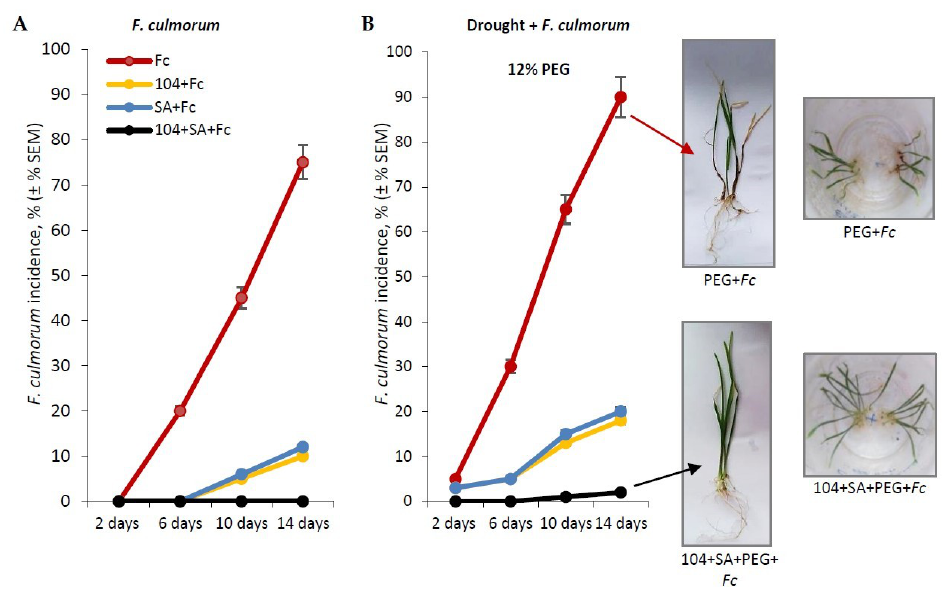
Figure 4. The influence of endophytic bacteria B. subtilis 10–4 (104) (10 5 colony‐forming units (CFU) mL −1 ), salicylic acid (SA) (0.05 mM), and composition of B. subtilis 10–4 + SA (104 + SA) on F. culmorum